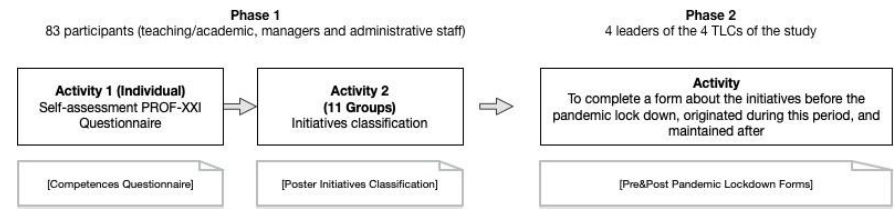
Figure 2. Phases of the different activities conducted for gathering all the data for the study.